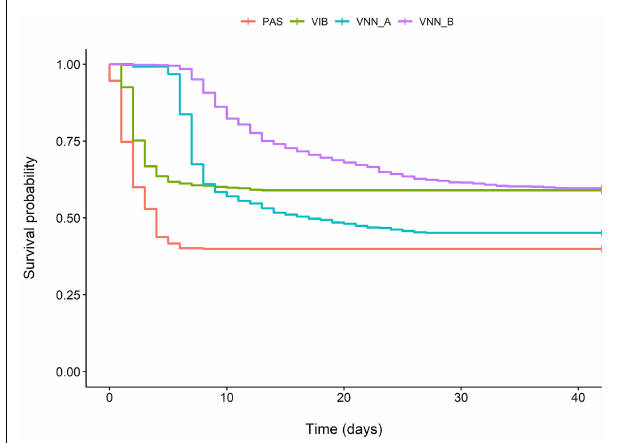
FIGURE 1 | Kaplan-Meier probability of survival over time following infection for two European sea bass commercial cohorts challenged to NNV (VNN_A and VNN_B), one European sea bass commercial cohort challenged to V. harveyi (VIB) and one gilthead sea bream commercial cohort challenged to Photobacterium damselae subsp. piscicida